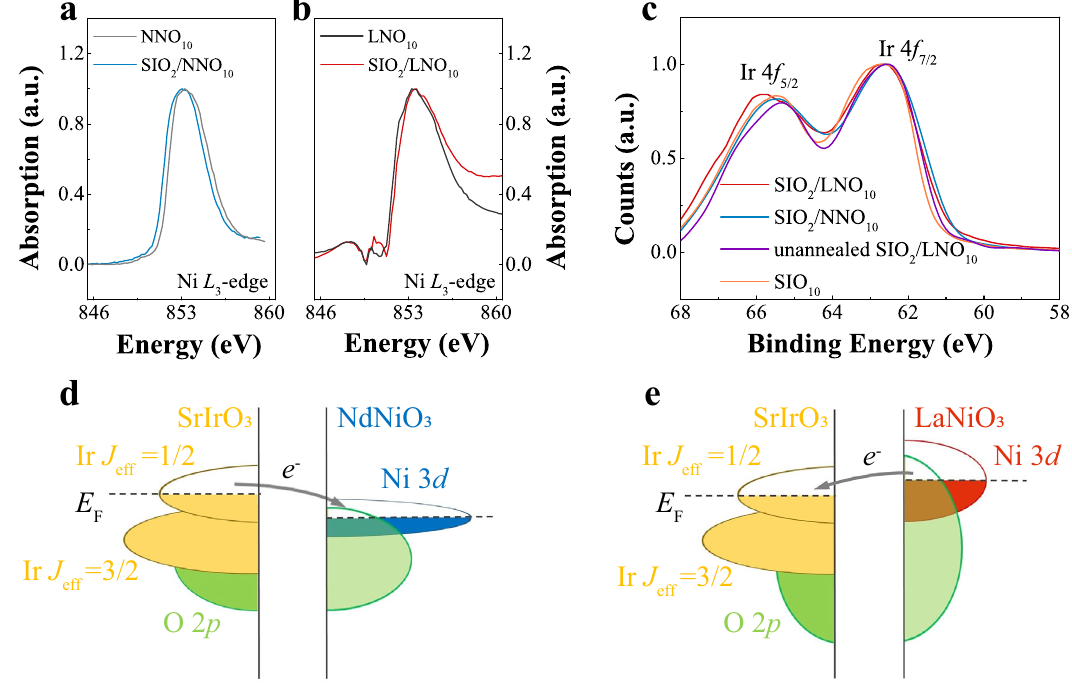
Fig. 2 Interfacial electron transfer. Ni L 3 -edge X-ray absorption spectra (XAS) of a (SrIrO 3 ) 2 /(NdNiO 3 ) 10 bilayer (blue line), abbreviated as SIO 2 /NNO 10 and b (SrIrO 3 ) 2 /(LaNiO 3 ) 10 bilayer (red line), abbreviated as SIO 2 /LNO 10 , in comparison with those of NNO 10 (gray line) and LNO 10 (black line) thin fi lms. The La M 4 -edge from the LNO components is fi tted with Gaussian-Lorentzian functions and subtracted. c Ir 4 f core level X-ray photoelectron spectra (XPS) of SIO 2 /NNO 10 (blue line) and SIO 2 /LNO 10 (red line) bilayers in comparison with those of SIO 10 (yellow line) thin fi lm and SIO 2 /LNO 10 bilayer unannealed in oxygen (purple line). Schematic density of states of d SIO and NNO, e SIO and LNO across the